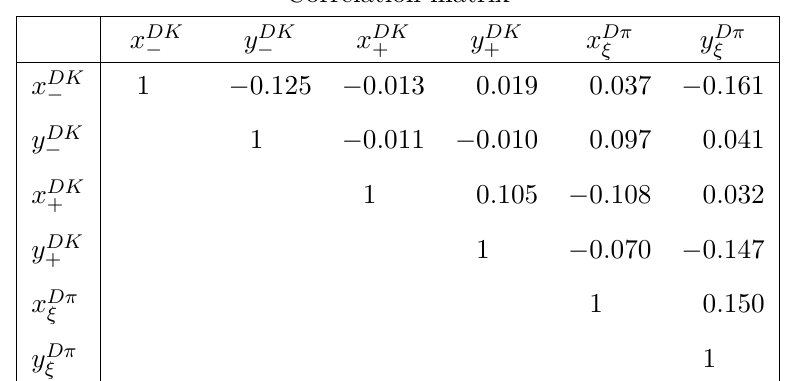
Table 3 . Statistical uncertainties, σ , and correlation matrix for x DK